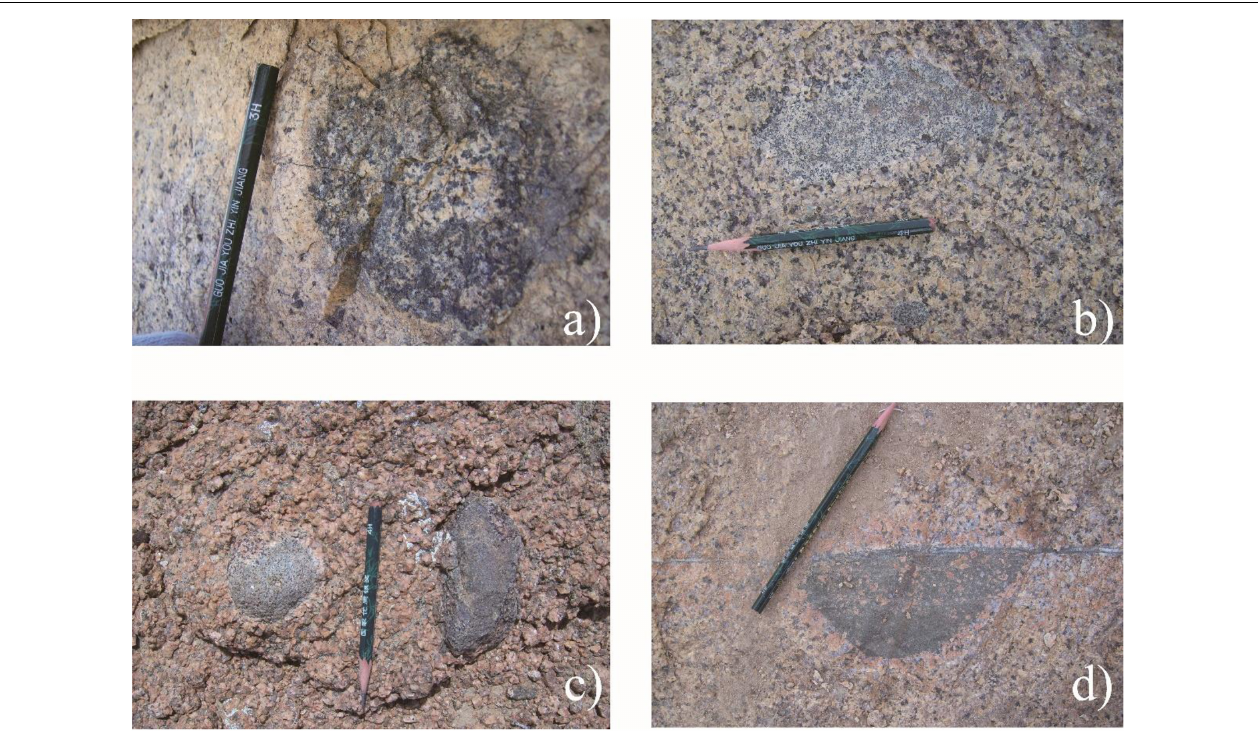
FIGURE 2 | Field photos of the enclaves in the Huangyangshan alkaline granite. (a–c) Both sharp and transitional boundaries exist indicating the rheology of magma during magma mixing. (d) Alkali feldspar of the host granites crosscuts the boundaries of the MME.